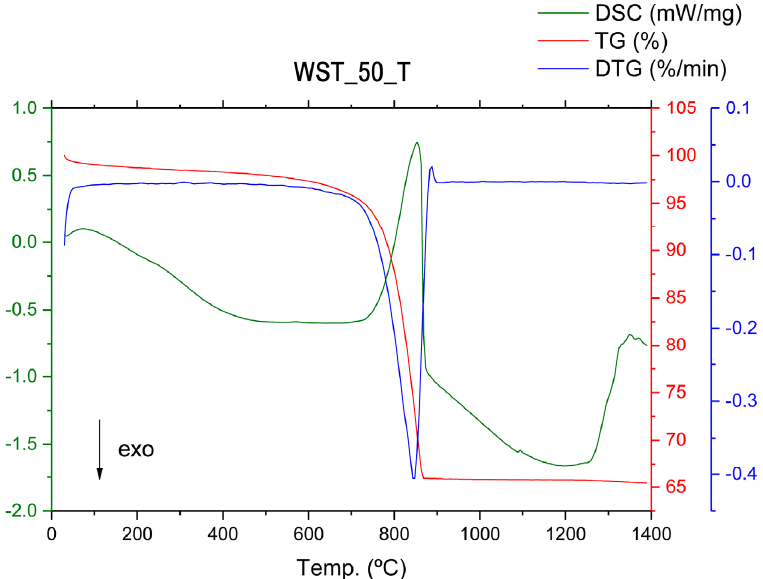
Figure 10. The TG (red line), DTG (blue line), and DSC (green line) analyses of crude-blend WST_50_T.